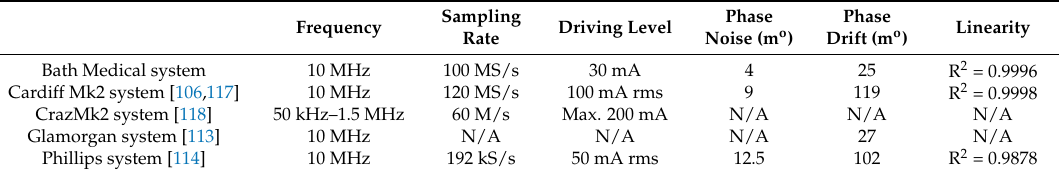
Table 2. The currently proposed MIT